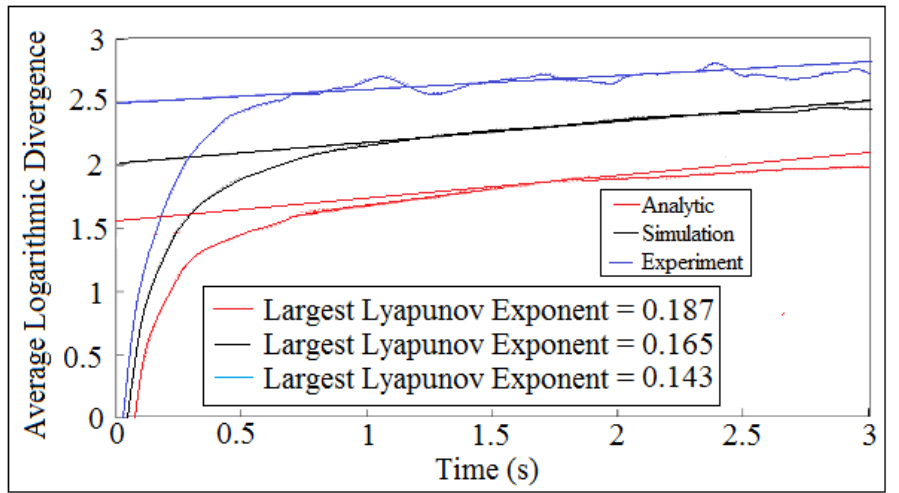
Figure 17. Average logarithmic divergence against time for (I.D. = 16 mm) and (N = 500 rpm) for profile no.(3).